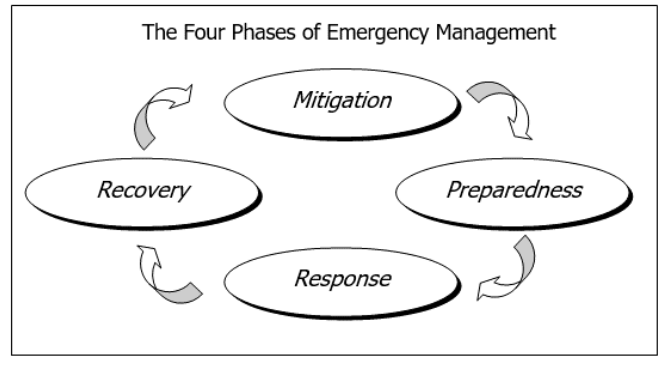
Fig. 1. Emergency management Fema